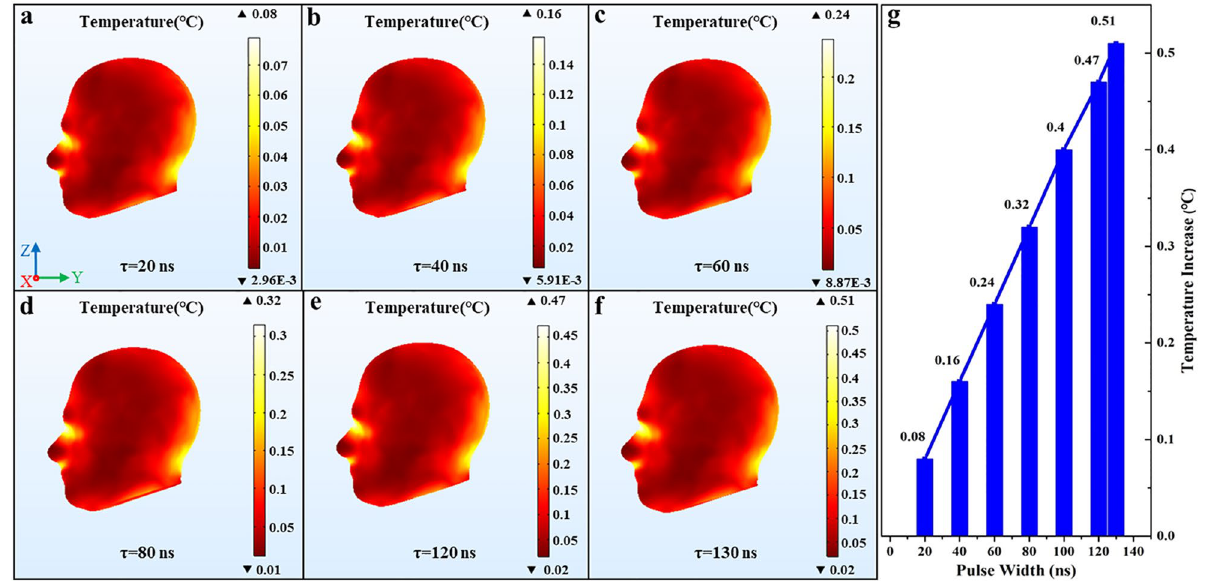
Figure 6. The temperature distribution in the human head and the variation curve of the temperature increase with different pulse width. ( a ) τ = 20 ns, ( b ) τ = 40 ns, ( c ) τ = 60 ns, ( d ) τ = 80 ns, ( e ) τ = 120 ns, ( f ) τ = 130 ns, ( g ) the variation curve of the temperature increase. We used COMSOL Multiphysics software, version 5.4 (https:// www. comsol. com/ comsol- multi physi cs) for simulation results (Images a – f ) and Origin software, version 8.0 (https:// www. origi nlab. com/ index. aspx? go= Produ cts/ Origin) for data analysis (Image g